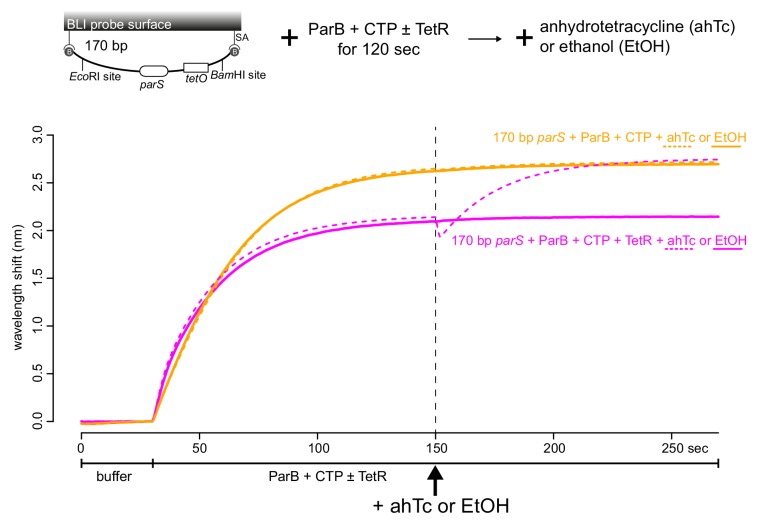
Anhydrotetracycline removes DNA-bound TetR roadblock and allows ParB to accumulate further on DNA.Anhydrotetracycline (3 μM) or ethanol (0.01%) was added after 1 μM Caulobacter ParB-His6 + 1 mM CTP ± 1 μM TetR and a 170 bp dual biotin-labeled parS DNA were preincubated together for 120 s. Mg2+ was included in all buffers for this experiment. A schematic of the DNA substrate is shown above the sensorgram.Figure 4—figure supplement 1—source data 1.Data used to generate Figure 4—figure supplement 1.